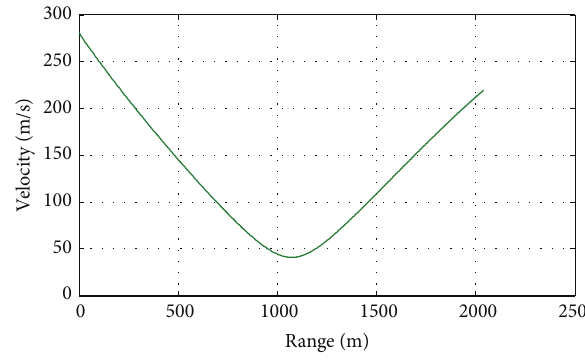
Figure 7: Roll rate.